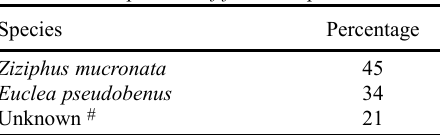
Composition of fuelwood